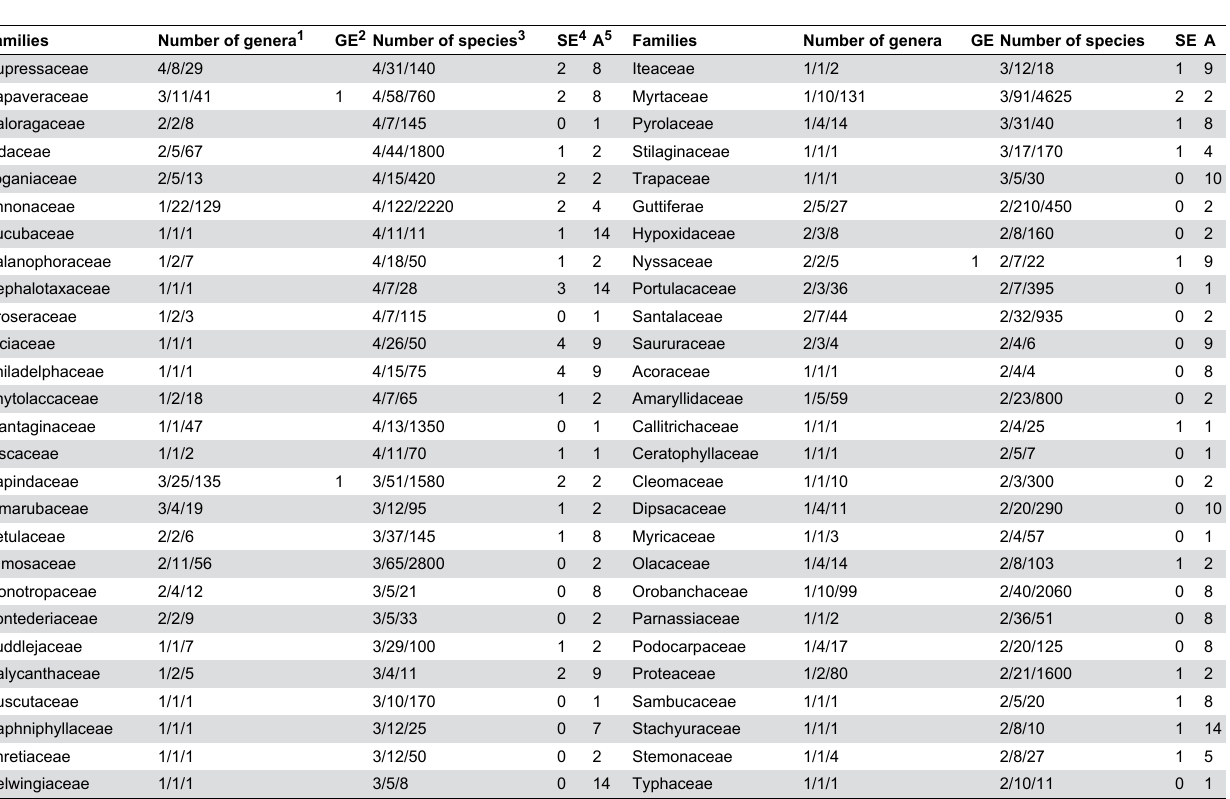
Table 5. Ranking of families (with 2-4 species) in Mount Jinggangshan region based on numbers of genera and species.